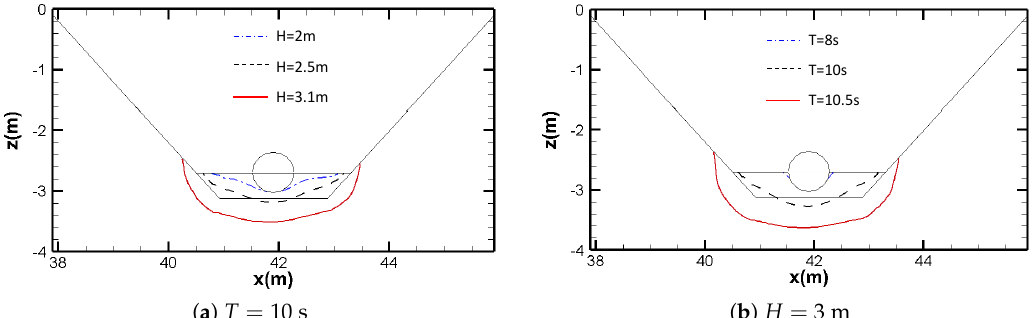
Figure 9. Distribution of the liquefaction depth around the partially buried pipeline for variable wave height and period.